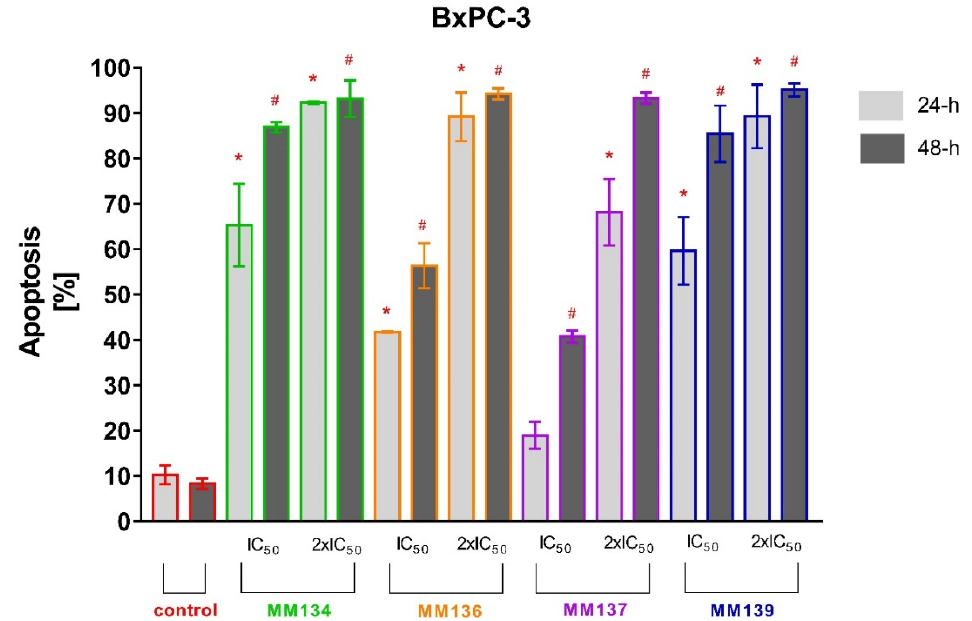
Figure 6. Determination of apoptosis induction in BxPC-3 cell line treated with IC 50 and 2xIC 50 concentrations of MM-compounds measured with Annexin V FITC. Data are presented as mean percentage of apoptotic cells (early and late apoptotic) ± SD values. The differences between the experimental samples and vehicle control were evaluated by the ANOVA test followed by Tukey’s test ( p < 0.05). * significant difference compared to the negative control (24 h incubation time); # significant difference compared to the negative control (48 h incubation time); p < 0.05; N = 1 × 10 4